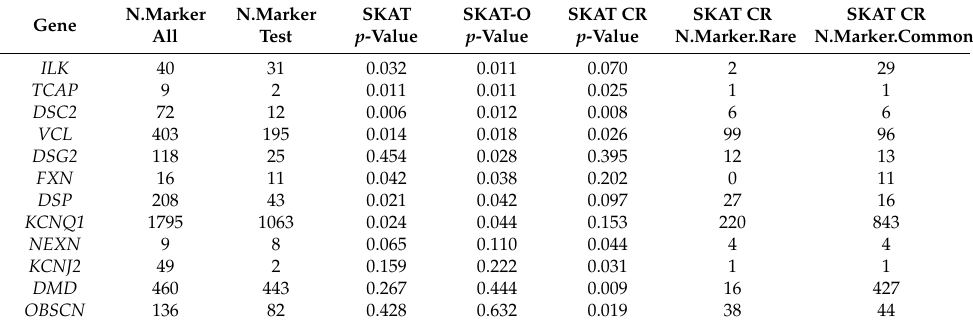
Table 3. Rare and common variant gene-based analyses of decline in LVEF following treatment with doxorubicin and trastuzumab, p < 0.05. Gene-based analyses were performed with SKAT, SKAT-O and SKAT CR (common/rare) functions. N.Marker All represents the total number of variants. N.Marker Test represents the number of variants used in the gene-based analyses (monomorphic variants are excluded). For the SKAT common/rare function, N.Marker.Rare is the number of analyzed variants with MAF < 0.025 and for N.Marker.Common, the number of analyzed variants with MAF < 0.025. Gene N.Marker All N.Marker Test N.Marker.Rare N.Marker.Common